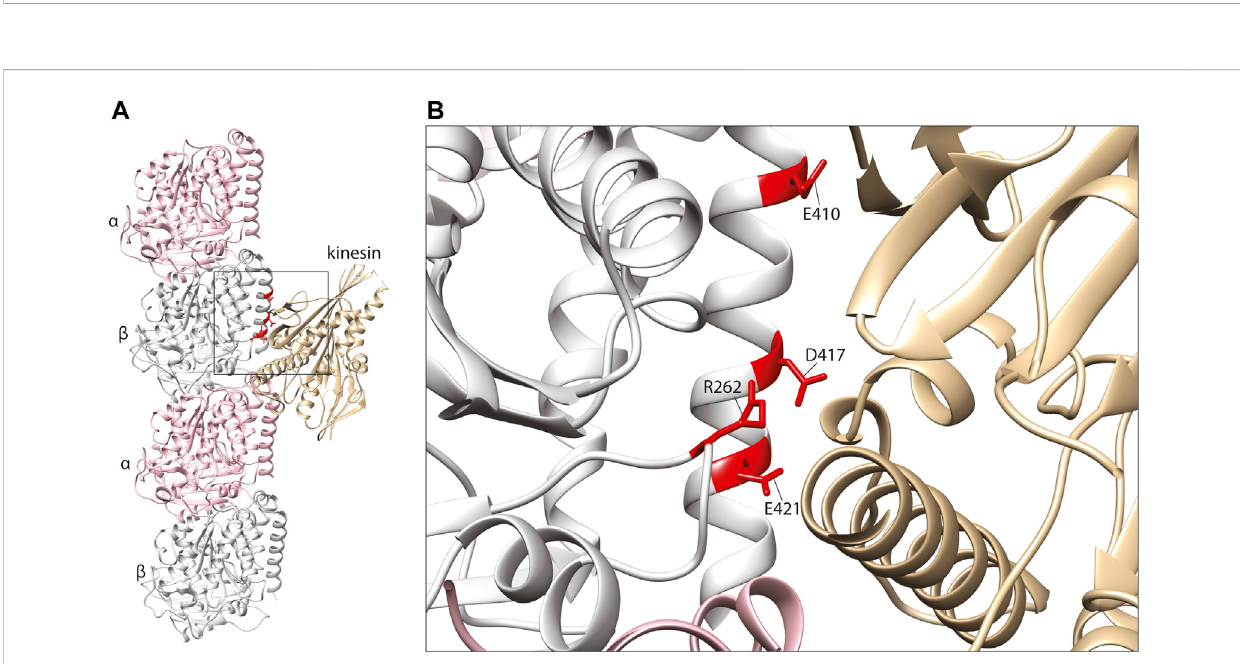
FIGURE 3 (A) Insilico homologymodelofamicrotubuleproto fi lament withboundkinesin. α -tubulinsare representedbyapink ribbon, β -tubulins insilverand kinesin in gold (PDB 6ZPI) (Atherton et al., 2020). (B) A detailed view of the predicted kinesin-interacting domain of β -tubulin. Mutated residues shown to effect kinesin binding and/or processivity shown in